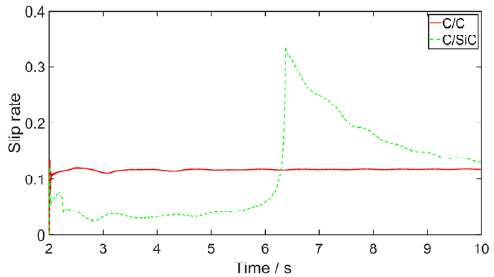
Figure 13. Comparison of wheel slip rate.